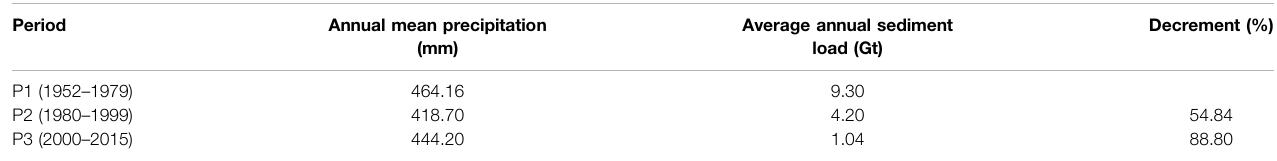
TABLE 2 | Statistics of precipitation and sediment